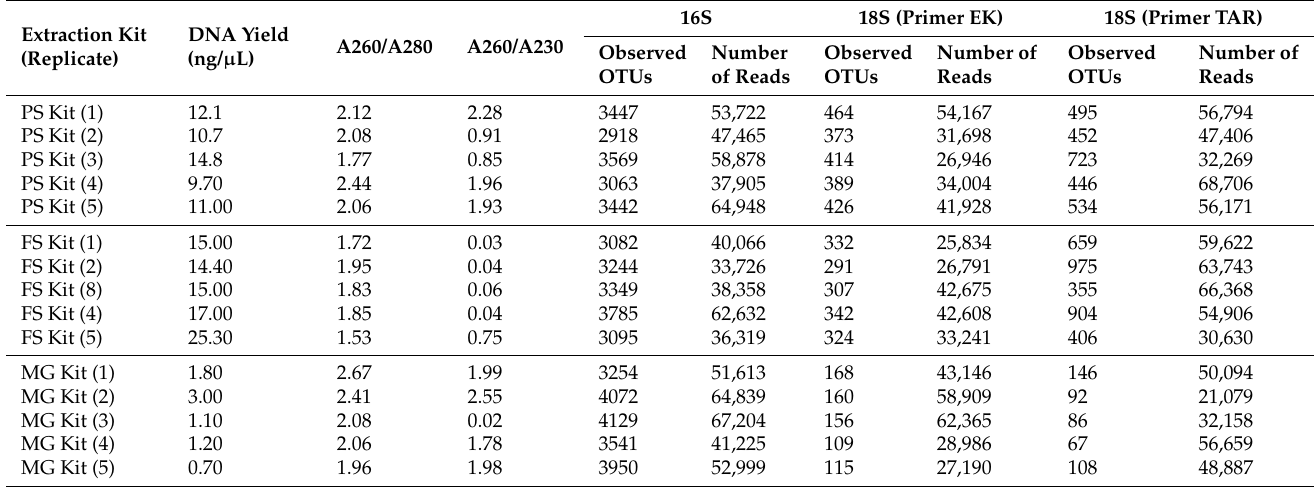
Figure 1. Comparison of DNA yields and quality between three extraction kits. DNA was eluted in a volume of 100 μ L for all three kits and qualified by the ratios of A260/A280 and A260/A230. Median values are indicated by the solid line within each box, and the box extends to upper and lower quartile values. Different letters above the box indicate they are statistically different ( p < 0.05/0.01). Table 1. Comparison of different DNA extraction kits on DNA yields, purity and number of OTUs *.